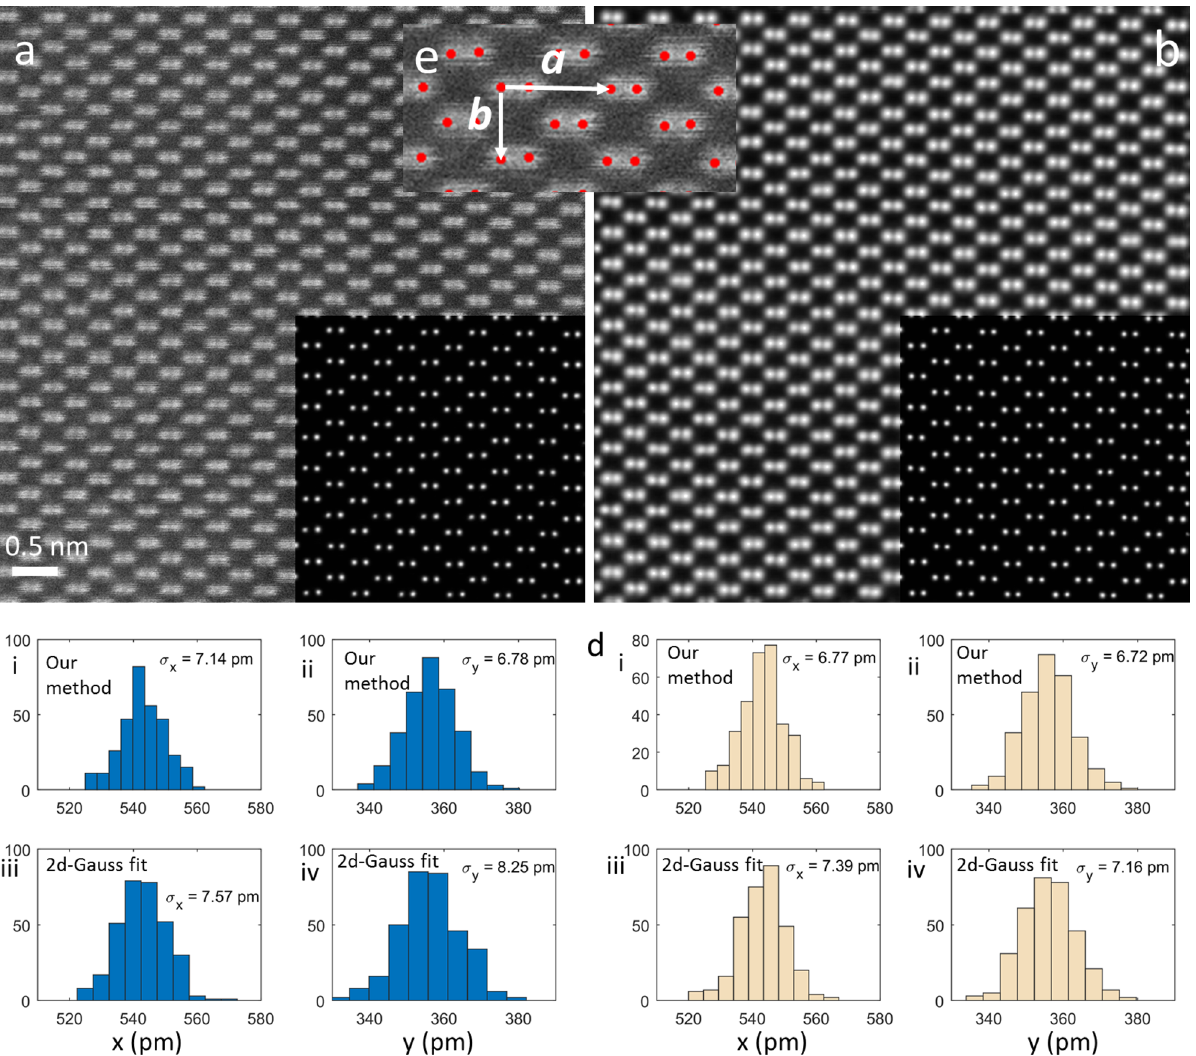
Figure 11. Precision analysis of our deep-learning model on an experimental ADF-STEM image. The pixel size of the image is 9.4 pm and the estimated peak signal-to-noise ratio is 21 db (12 in linear scale). ( a ) The ADF-STEM image of Si [110]. Inset: the atomic-column Gaussian map. ( b ) The image after denoise + background removal processing. Inset: the atomic-column Gaussian map. ( c , d ) The precision analysis. (e) The illustration of the a and b